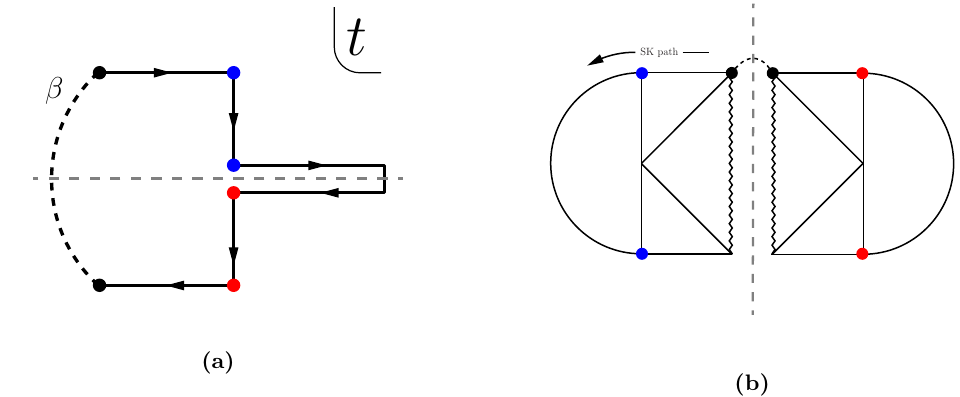
Figure 7. (a) The adequate SK path for a finite high temperature scenario is presented. This is essentially a standard Thermal path duplicated such that it can fit the number of asymptotic boundaries for a two-sided BH holographic dual. (b) The BTZ dual to the SK path on the left. The high temperature scenario is reflected in the bulk as wormholes connecting asymptotic boundaries through the